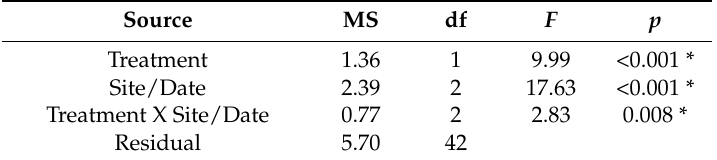
Table 4. Two-way PERMANOVA comparing the composition of interstitial invertebrate assemblages across Treatments ( Porphyra removal vs. Control plots) and experimental Sites/Dates (Punta Cantera/2011, Las Brusquitas/2015, and Copacabana/2017). Asterisks indicate significant effects.